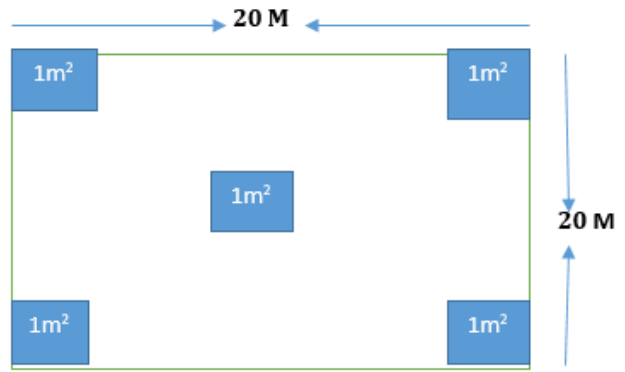
Figure 2. Field plot layout of the experimental site. Each 20 m × 20 m (400 m 2 ) plot was used for tree/shrub sampling, and the 1 m 2 quadrat nested within was used for sampling herb biomass and soil physicochemical properties.